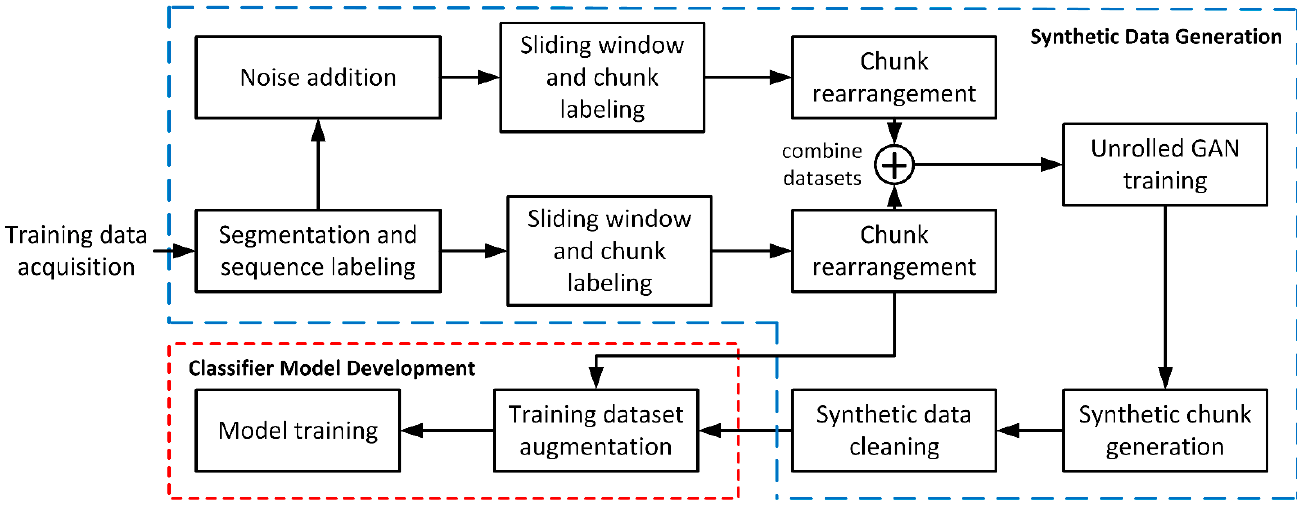
Figure 2. An overview of the proposed approach.